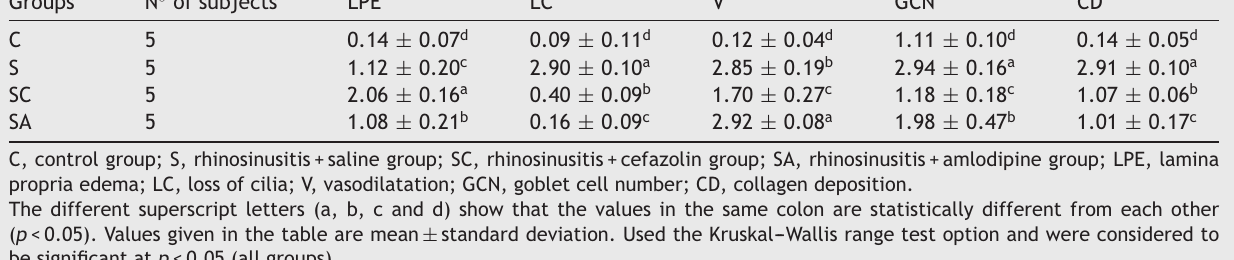
The statistical results of semi-quantitative assessment of histopathological changes of all groups. Groups